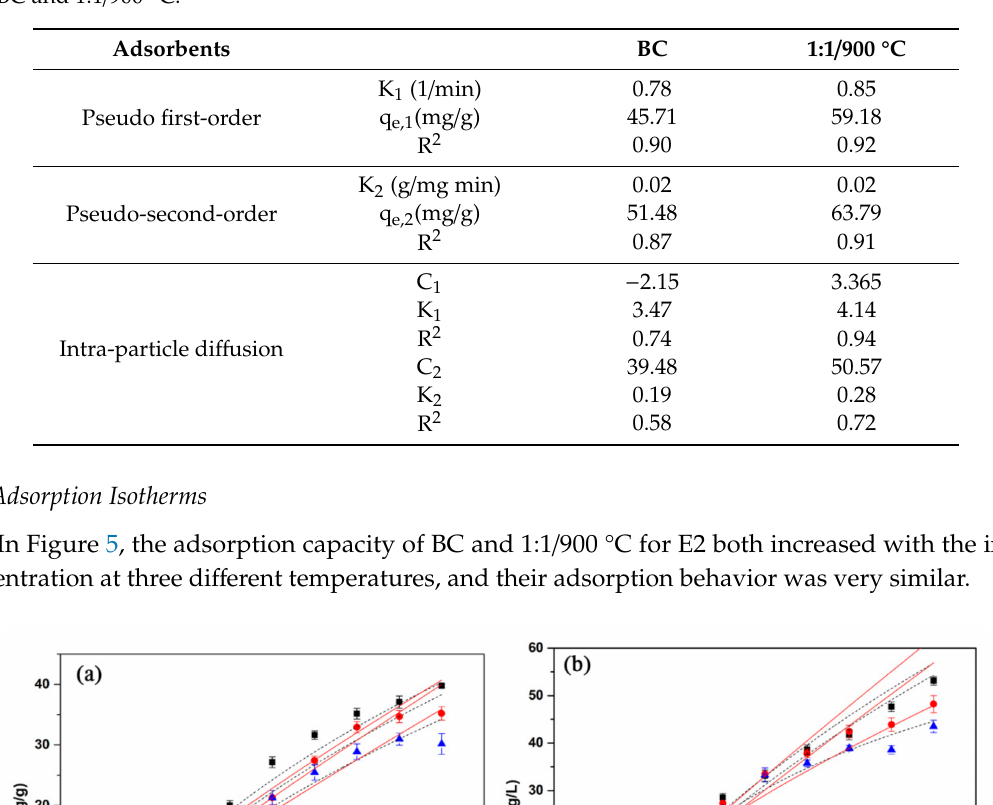
Table 3. Pseudo-first-order and pseudo-second-order equation model parameters for E2 adsorption on BC and 1:1 / 900 ◦ C.